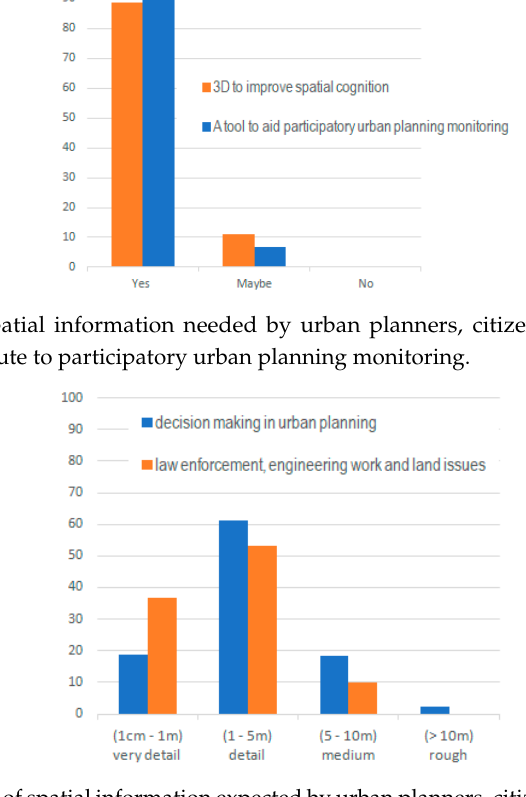
Figure 10. The quality of spatial information expected by urban planners, citizens, and non-government institutions in participatory urban planning monitoring.